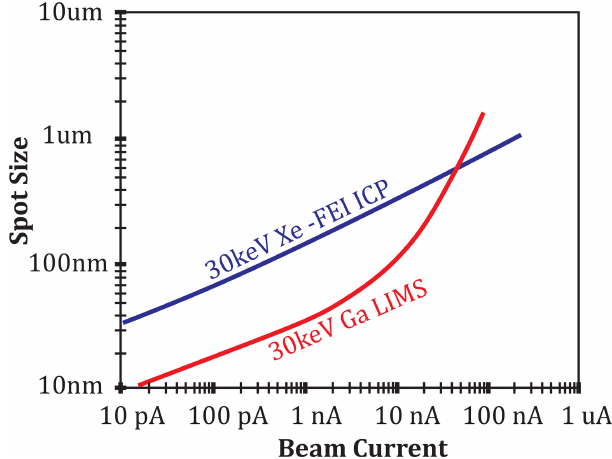
Figure 1. Spot size versus beam current for Xe + - and Ga + -source focused ion beam (FIB) instruments. At higher beam currents ( > 10nA) the spot size generated by the liquid-metal-ion-source (LMIS) Ga + FIB exponentially increases due to spherical aberra- tion, limiting the energy that can be applied during milling. The inductively coupled Xe-pFIB source remains stable at higher cur- rents, yielding a linear increase in spot size with beam current and allowing higher energies to be applied without sacrificing spatial precision. This opens the door to larger-scale (millimetre) milling experiments, such as extracting whole mineral phases from thin sec- tion or grain mount. Adapted from Burnett et al.